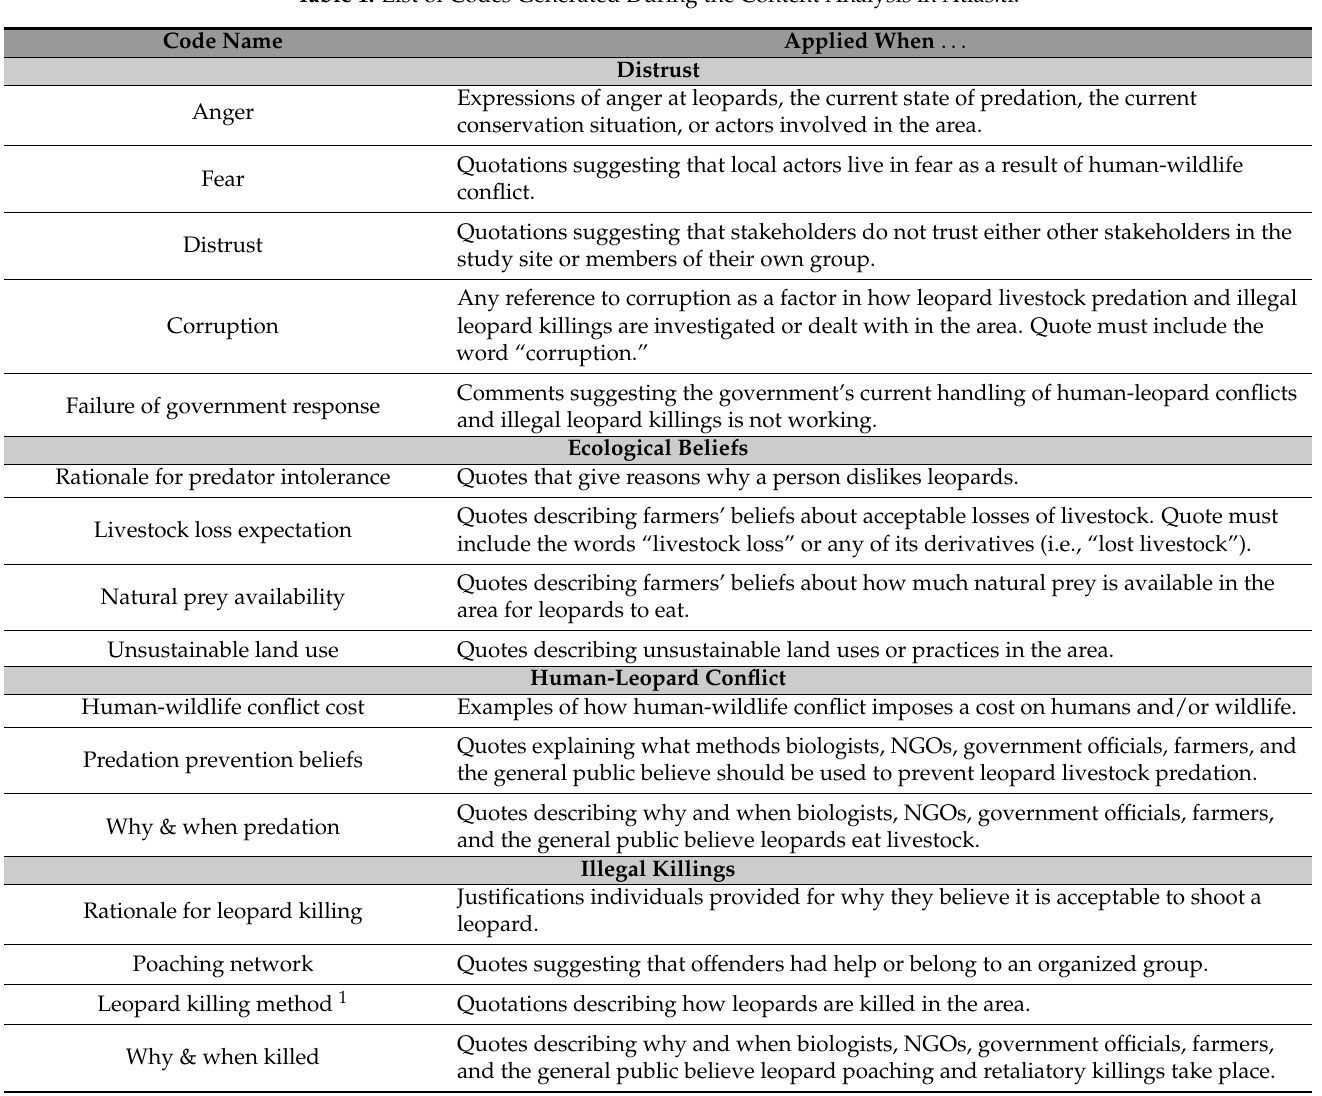
Table 1. List of Codes Generated During the Content Analysis in